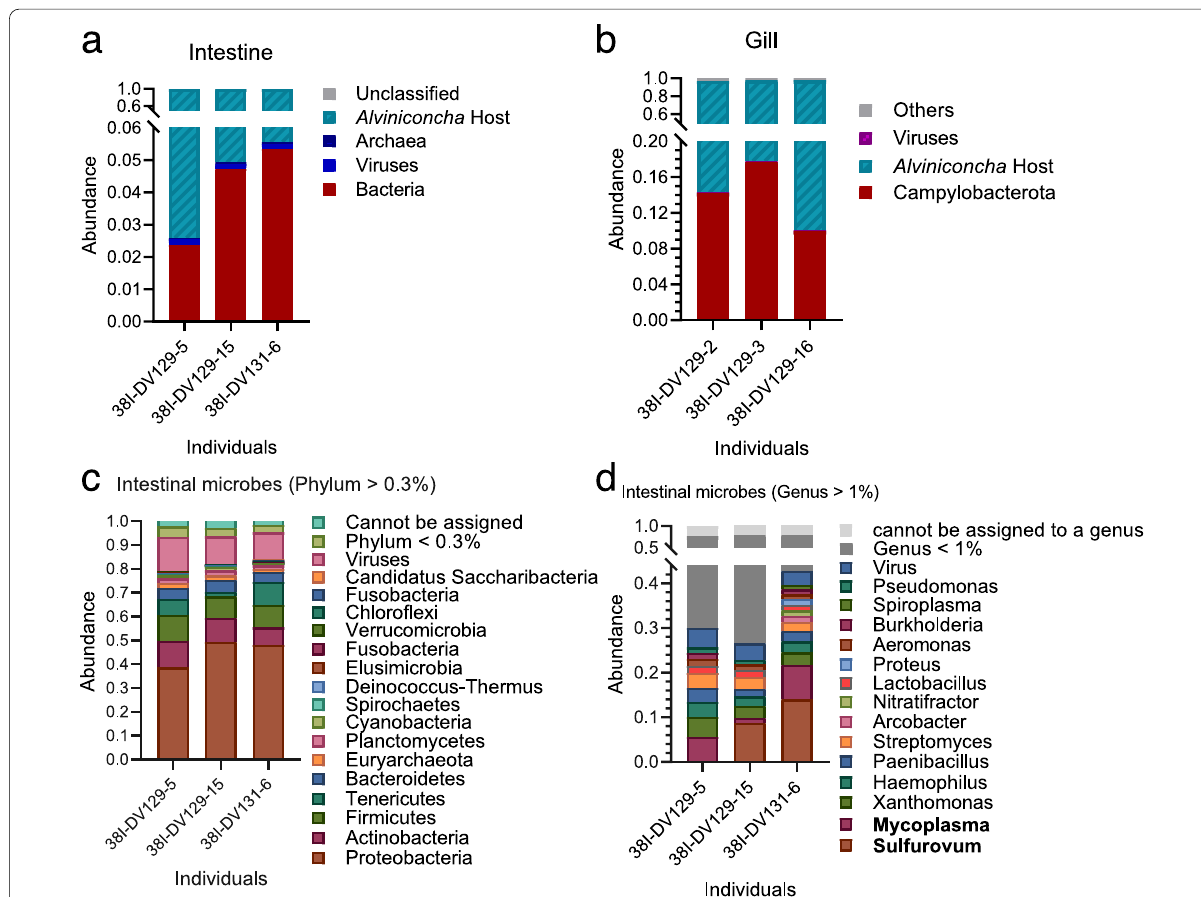
Fig. 1 Abundance and community structure of microbiomes in the intestines of Alviniconcha marisindica from the Wocan vent field. Microbial taxonomic structures are deduced from the intestinal and gill metagenomes. The abundance of bacteria in a intestines and b gills are indicated in red colour. The microbial community compositions of intestines are displayed at the phylum and genus levels on the basis of Kaiju classification. c Phylum totalling > 0.3% and d genus totalling > 1% of the samples are